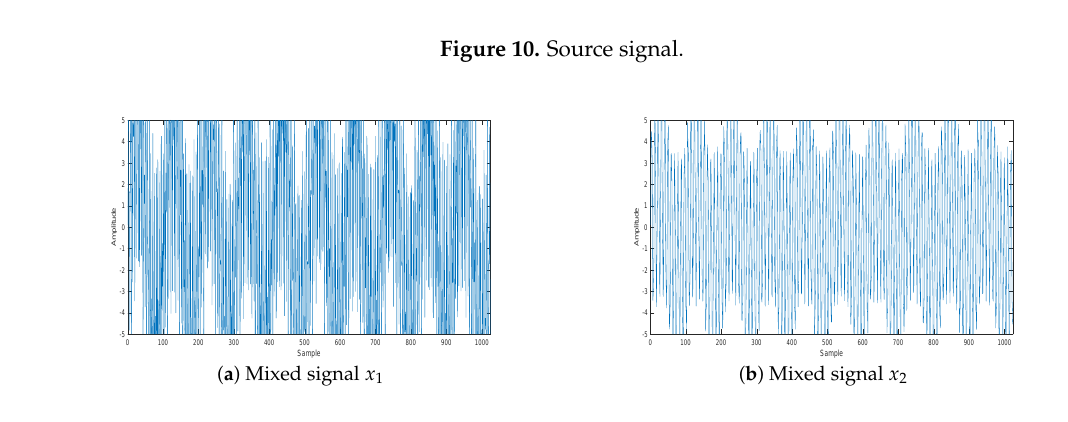
Figure 11. Mixed signal by sensors.